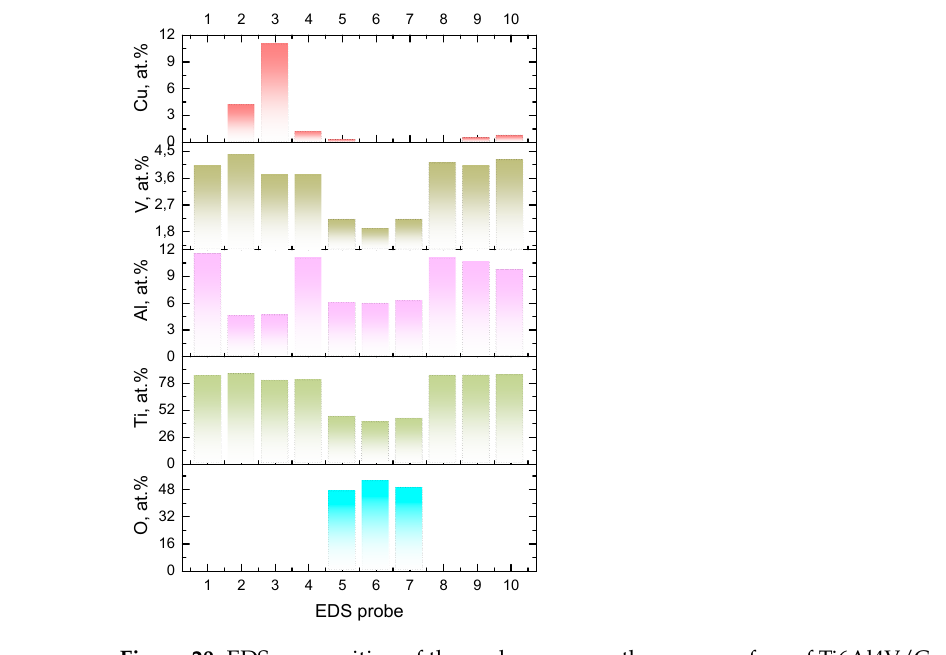
Figure 20. EDS composition of the probe zones on the worn surface of Ti6Al4V/Cu (Figure 19).